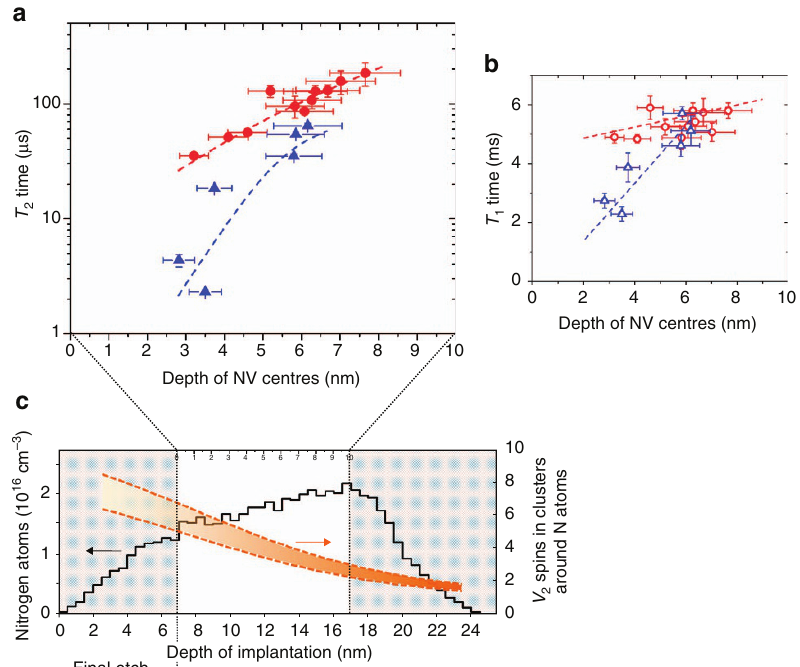
Figure 3 | Enhanced spin properties of NV centres at the sample area. ( a , b ) T 2 (Hahn echo) and T 1 times, respectively, of individual NV centres as a function of depth at the ‘Sample’ (circles) and ‘Reference’ (triangles) areas (magnetic field of B 33mTaligned to the NVaxis). The depth of each NVcentre was measured independently by spin relaxation technique using gadolinium (Gd 3 þ ) ions deposited on the diamond surface. Dashed-lines are guides to the eye. The error bars correspond to the s.d. of the data fit. ( c ) Depth profile of nitrogen atoms by CTRIM simulation for 5.0keV implantation energy (10 10 cm (cid:2) 2 ion fluence) in [100]-oriented diamond for an incident angle of 3 (cid:2) 30,35,37 . The two vertical dashed lines align the projected depth of the implanted nitrogen atoms to the experimental depth range of NVcentres measured by spin relaxation technique, after the final etching of 7nm. The orange lines delimit our simulated distribution profile of di-vacancies (30–40% of single vacancies are converted to di-vacancies within defect clusters, see